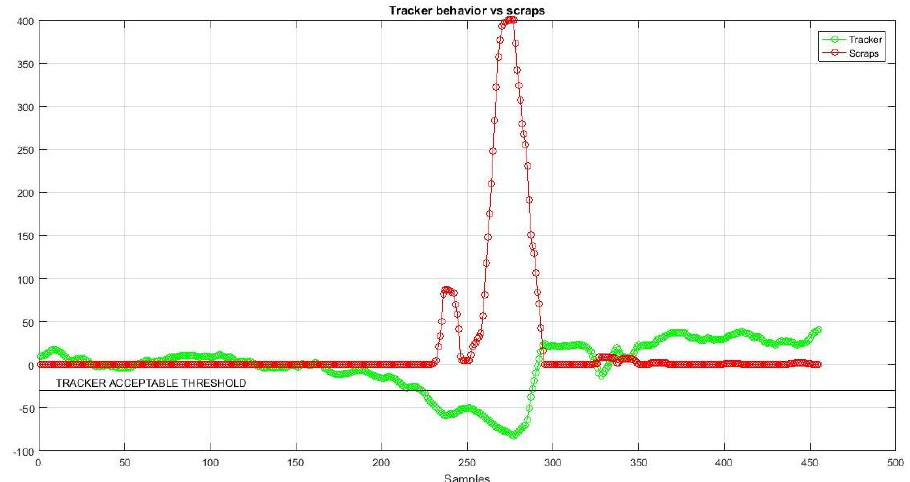
Figure 8. Optimal tracker time series (green curve) vs. number of scraps per sample (red curve), referring to flow rate of Figure 10. The outcome of SA first step suggests to use N = 400, M = 40, T = −29.5237 and to combine μ, σ, P u, P l, Cp u, Cp l, θ, Δ to build the tracker. Each point represents the tracker value for a sample of N products while the black line stands for the admissible threshold computed for the tracker.